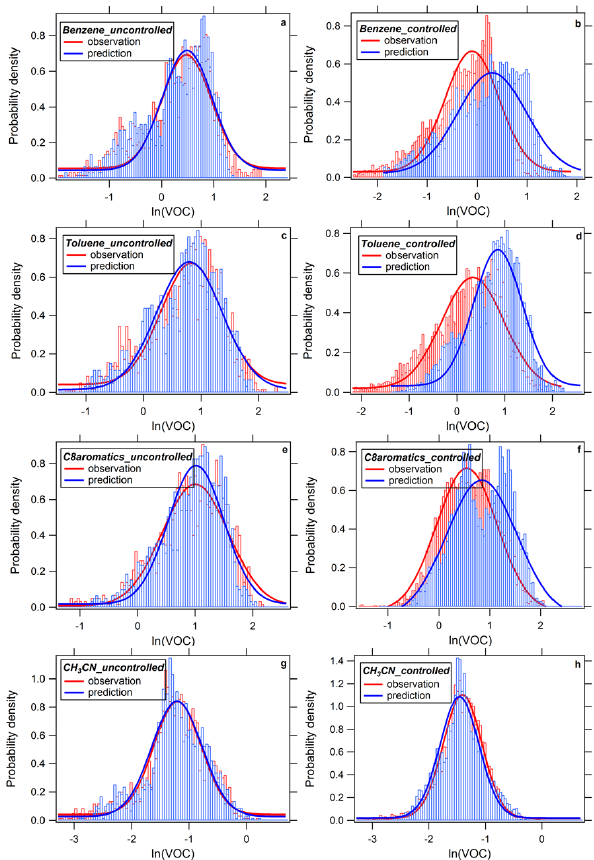
Figure 3. Probability density distribution of the observed ln(VOC) (red) and the predicted values (blue) before the full control (left column) and after the full control (right column) for OVOC species: (a, b) methanol, (c, d) HCHO, (e, f) acetaldehyde, and (g, h)